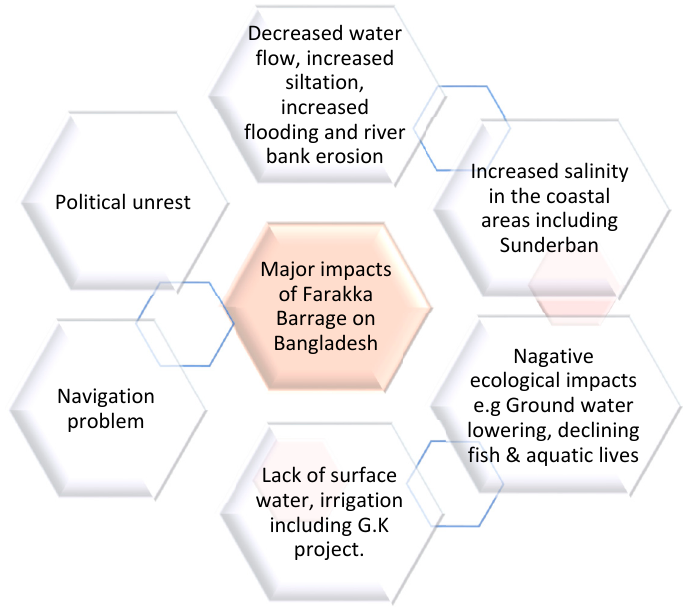
Figure 3. Impacts of Farakka Barrage on Bangladesh hydrology